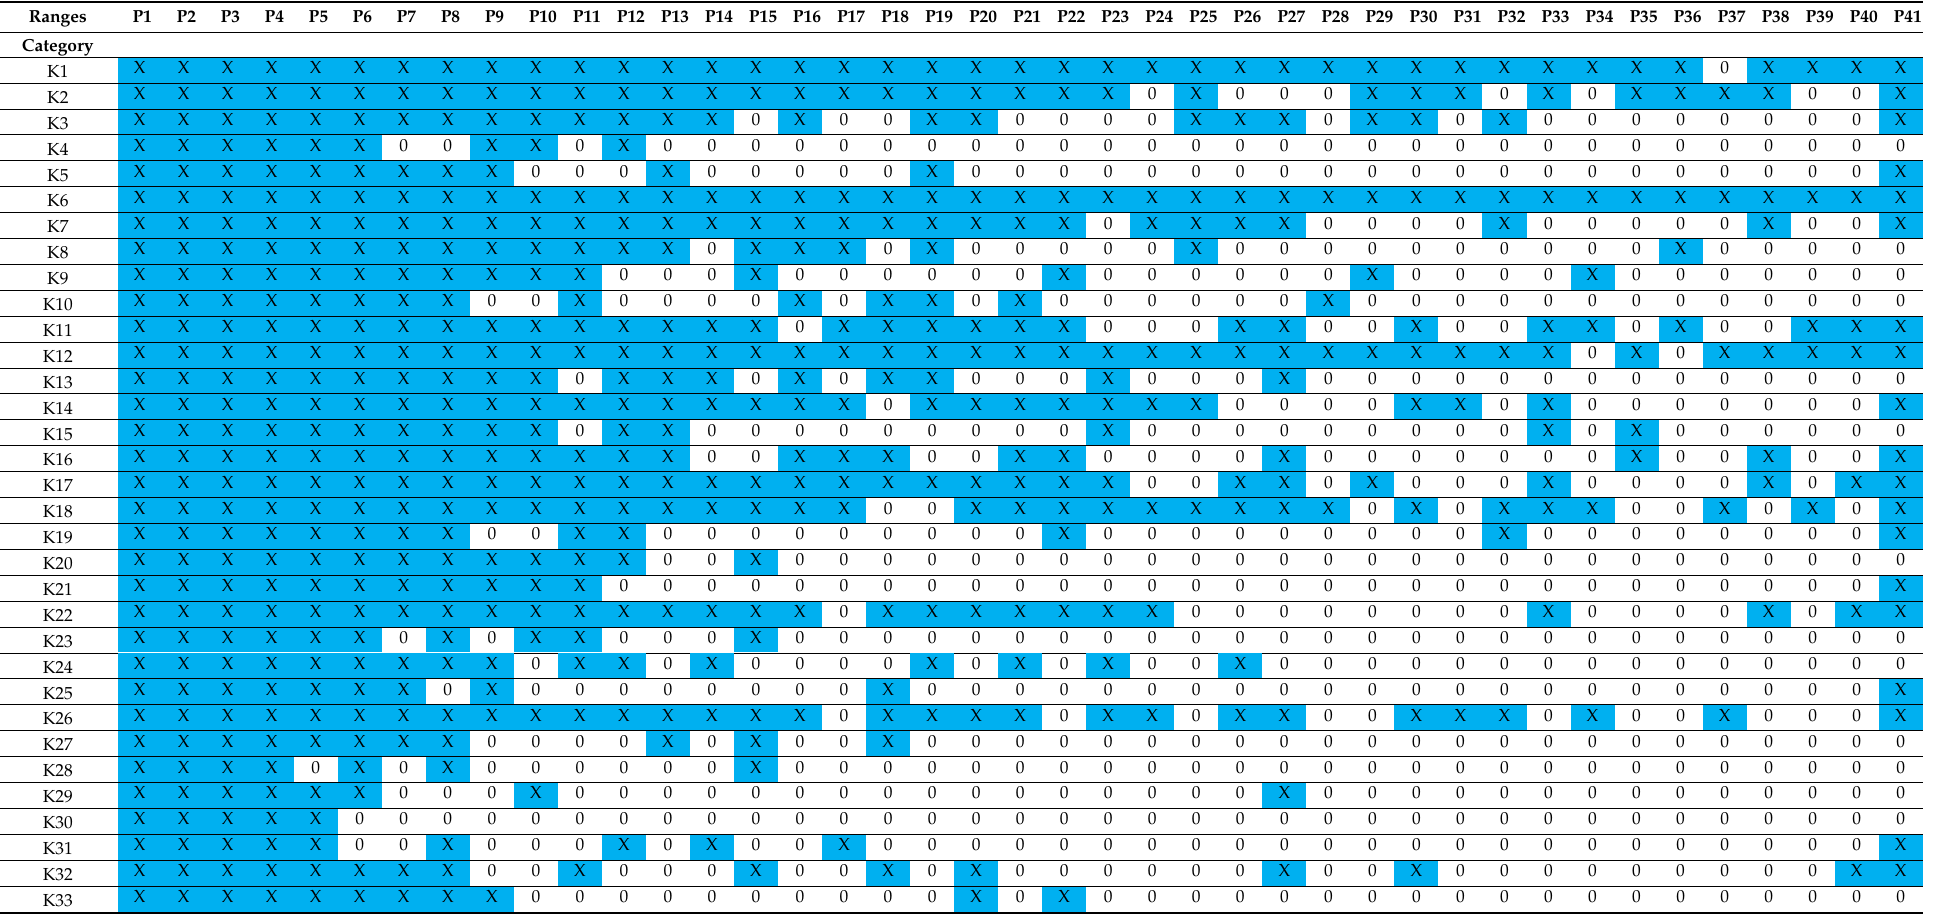
Table 9. KA matrix: project categories according to the number of people backing the